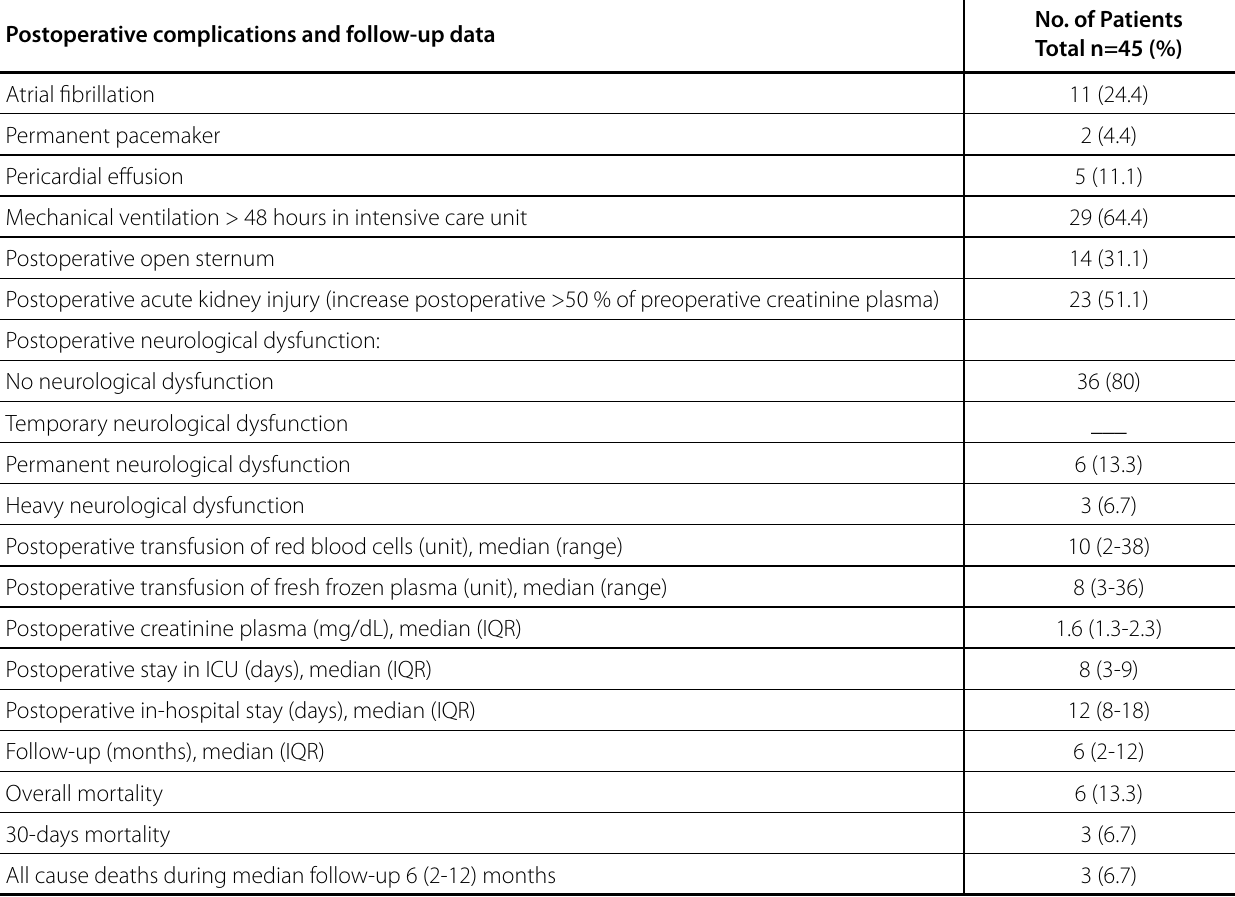
Table 3 . Postoperative complications and follow-up data. Postoperative complications and follow-up